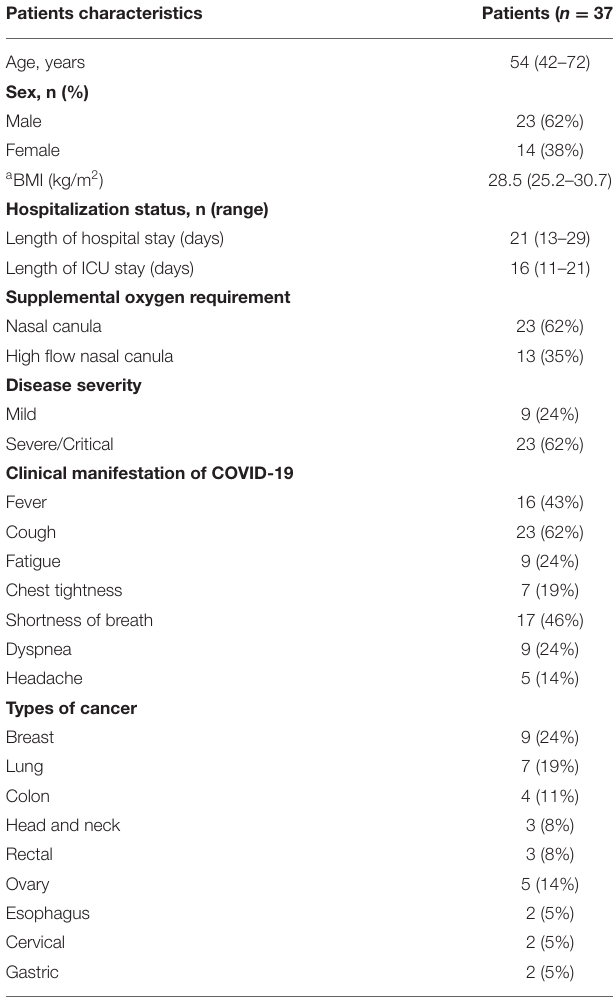
TABLE 1 | Characteristics of patients with cancer who were infected with SARS-CoV-2 before starting anticancer treatment. Patients